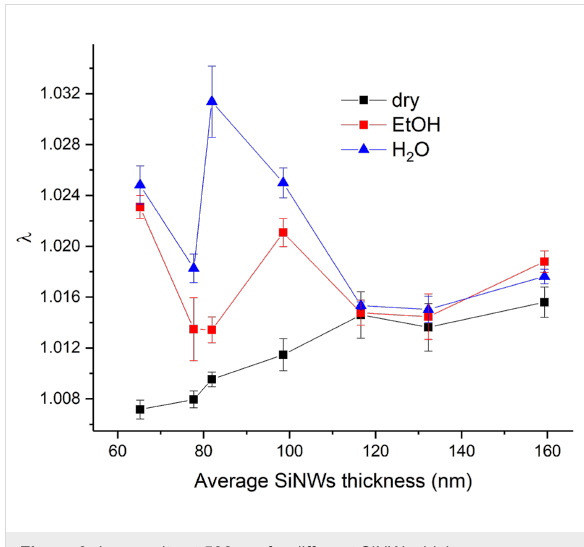
Figure 9: Lacunarity at 532 nm for different SiNWs